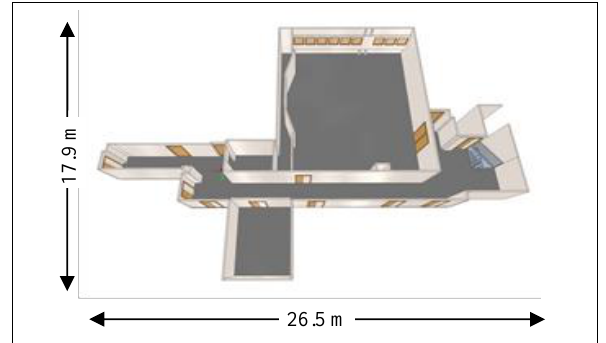
Figure 3. 3D model of the test environment. The ceiling is removed to give a better impression of the interior.